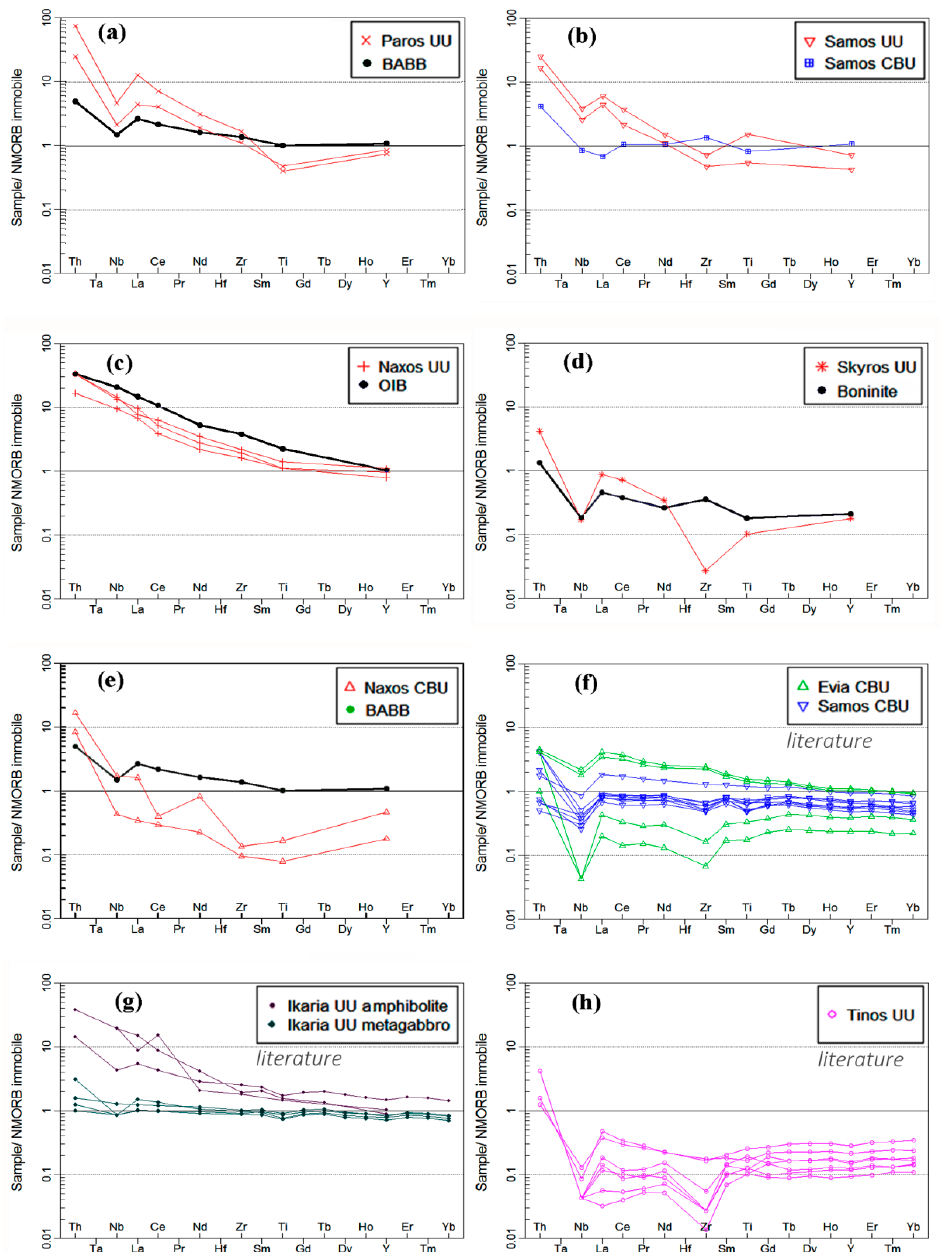
Figure 7. Incompatible, immobile element patterns (spidergrams) for Aegean ophiolites along with some typical basaltic compositions from different tectonic setting. Data sources, see [51] and references in the text; BABB from [52]; Boninite from [66]. Normalisation is to N-MORB [51]. ( a ) Paros; ( b ) western Samos-Kallithea nappe and central Samos (CBU) metagabbros; ( c ) Naxos metabasalts (UU); ( d ) Skyros metadolerite (SK-1); ( e ) Naxos amphibolites (CBU) from the flanks of the gneiss dome; ( f ) central Samos CBU) and southern Evia (CBU) metagabbros from [15]; ( g ) Ikaria upper unit (Faros and Kefala units from [10]); ( h ) Tinos-Mt Tsiknias (Upper Unit) metagabbros from [15].